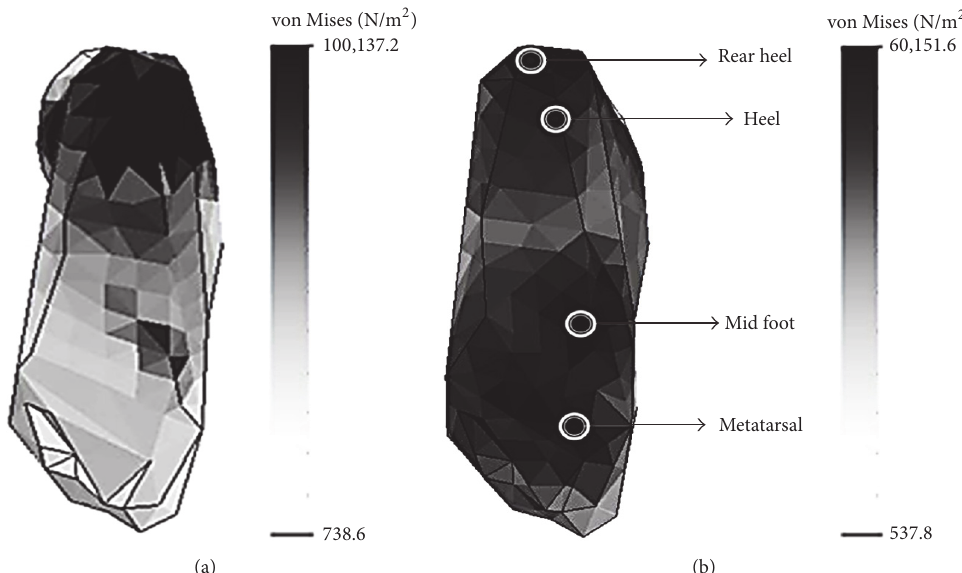
Figure 2: Flat (a) and custom-molded (b) insoles stress graph. Insoles thickness, elasticity, and degree are 0.5 cm, 2000 MPa, and 0 ∘ regularly. The maximum stress in the custom-molded insole is 40% less than the flat insole. Moreover, the stress has a more uniform spread in the custom-molded insole.